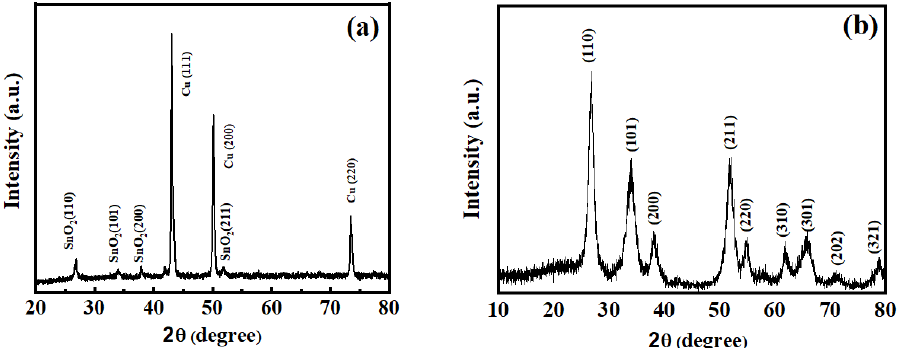
Figure 2. XRD pattern of SnO 2 : ( a ) nanosheets on the CMF; ( b ) nanosheets after HNO 3 treatment.